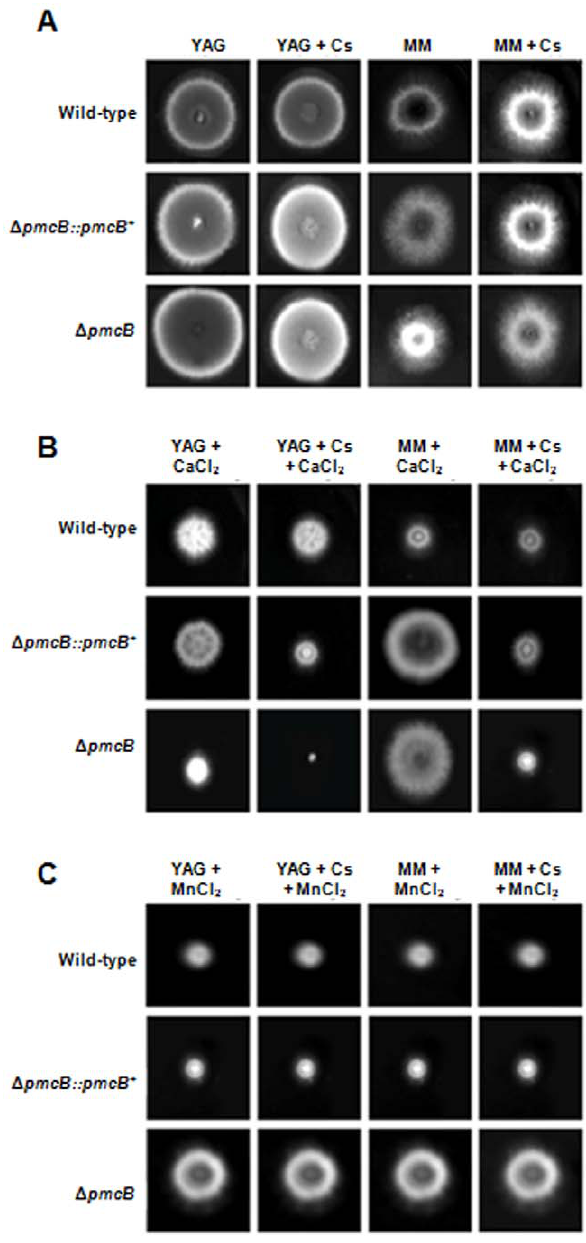
Figure 6. Growth phenotypes of the D pmcB mutant strain. The A. fumigatus wild-type, D pmcB::pmcB and D pmcB mutant strains were grown for 72 hours at 37 u C in (A)YAG, YAG + 25 ng/ml cyclosporin (Cs), MM, or MM + 25 ng/ml Cs; (B) YAG + 500 mM CaCl 2 , YAG + 25 ng/ml Cs + 500 mM CaCl 2 , MM + 500 mM CaCl 2 , or MM + 25 ng/ml Cs + 500 mM CaCl 2 ; (C) YAG + 25 mM MnCl 2 , YAG + 25 ng/ml Cs + 25 mM MnCl 2 , MM + 25 mM MnCl 2 , or MM + 25 ng/ml Cs + 25 mM MnCl 2 .